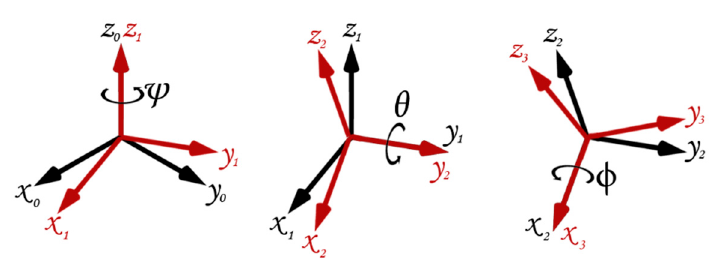
Figure A2. Rotation around Z, Y, and X representation.